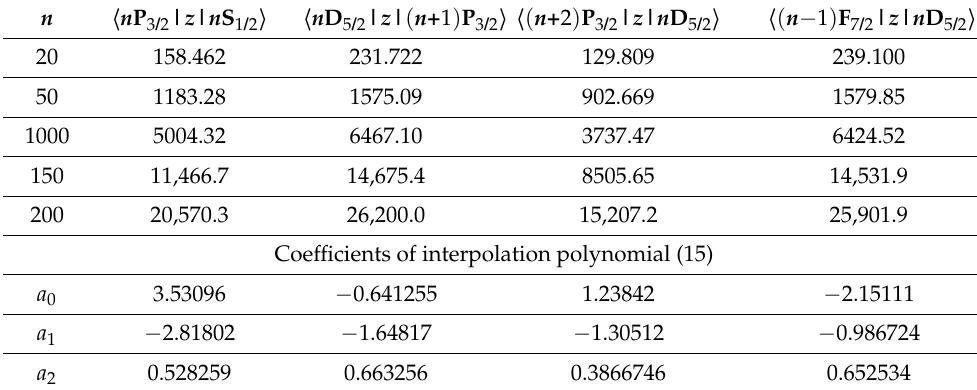
Table 11. The same as in Table 7, for Cs atoms. The corresponding transition frequencies are presented in Table 6. The subscripts determining the total angular momentum j = L + 1